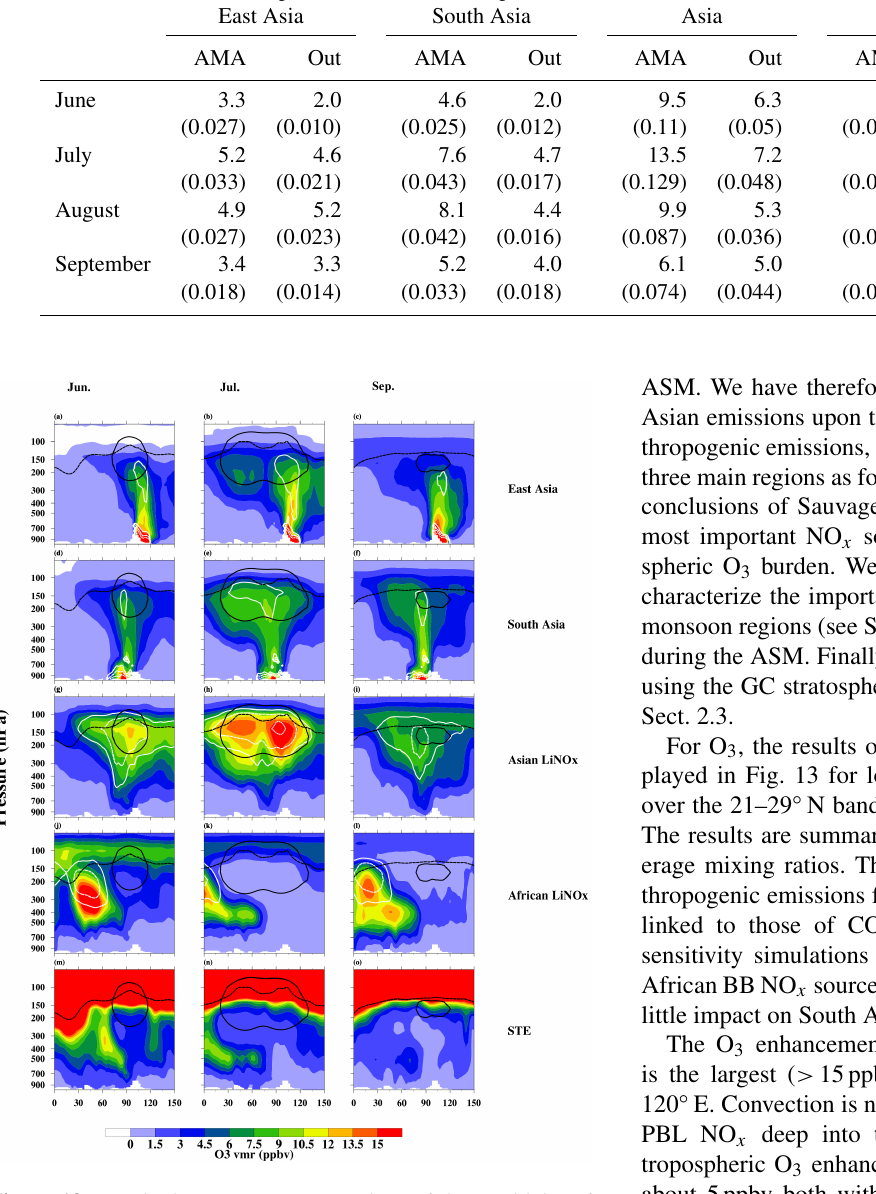
Figure 13. Longitude–pressure cross sections of the sensitivity of O 3 to NO x sources averaged over 23–29 ◦ N for (a, b, c) East Asian anthropogenic, (d, e, f) South Asian anthropogenic, (g, h, i) Asian lightning and (j, k, l) African lightning computed as the difference between the control run and simulations with the corresponding source switched off. Panels (m, n, o) correspond to tagged strato- spheric O 3 to diagnose STE. From left to right, panels correspond to monthly means with (a, d, g, j, m) June, (b, e, h, k, n) July and (c, f, i, l, o) September 2009. The white solid, dashed and dotted lines correspond to the 50, 100 and 200pptv contours, respectively, for the sensitivity of NO x to the different NO x